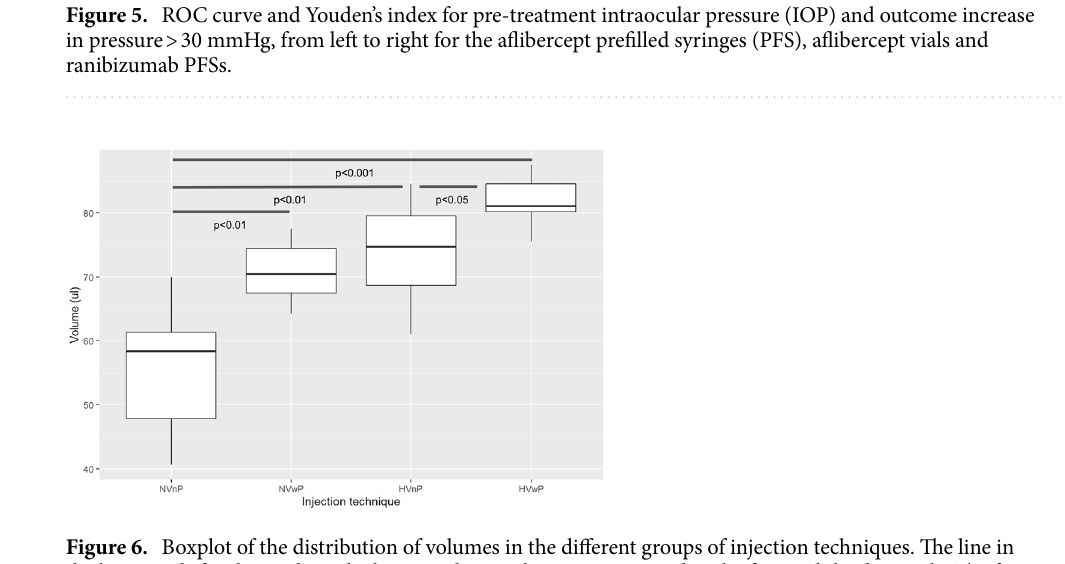
Figure 6. Boxplot of the distribution of volumes in the different groups of injection techniques. The line in the box stands for the median, the lower and upper hinges correspond to the first and third quartile. The four different groups are Normal Volume without forced Pressure (NVnP) or with forced Pressure (NVwP) at the end of emptying the syringe and High Volume without or with forced Pressure (HVnP and HVwP groups). The p-values under the blue lines indicate the pairwise comparisons using t-tests with non-pooled standard deviations (SD). Note that SD are higher within the groups in which no forced pressure at the end of emptying the syringe was used, indicating higher variability of ejection